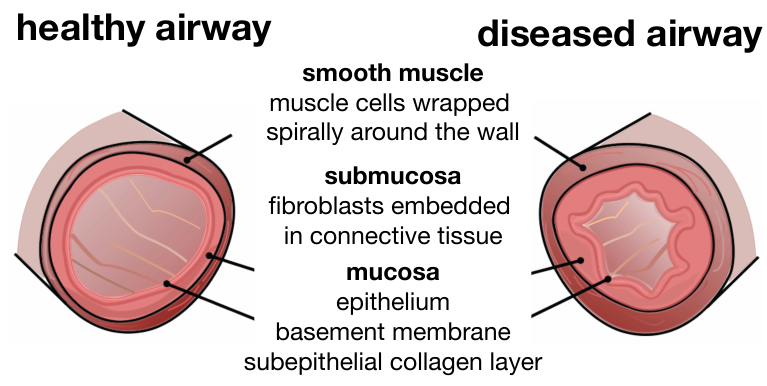
Figure 3. Schematic of the airway wall. Small airways consist of three distinct layers, the mucosa, the submucosa and the smooth muscle layer. In chronic lung disease, the smooth muscle layer thickens and creates an elevated pressure at the outer wall, while the mucosal layer experiences inflammation and increases in volume at the inner wall. The airway wall folds inwards, resulting in progressive airflow